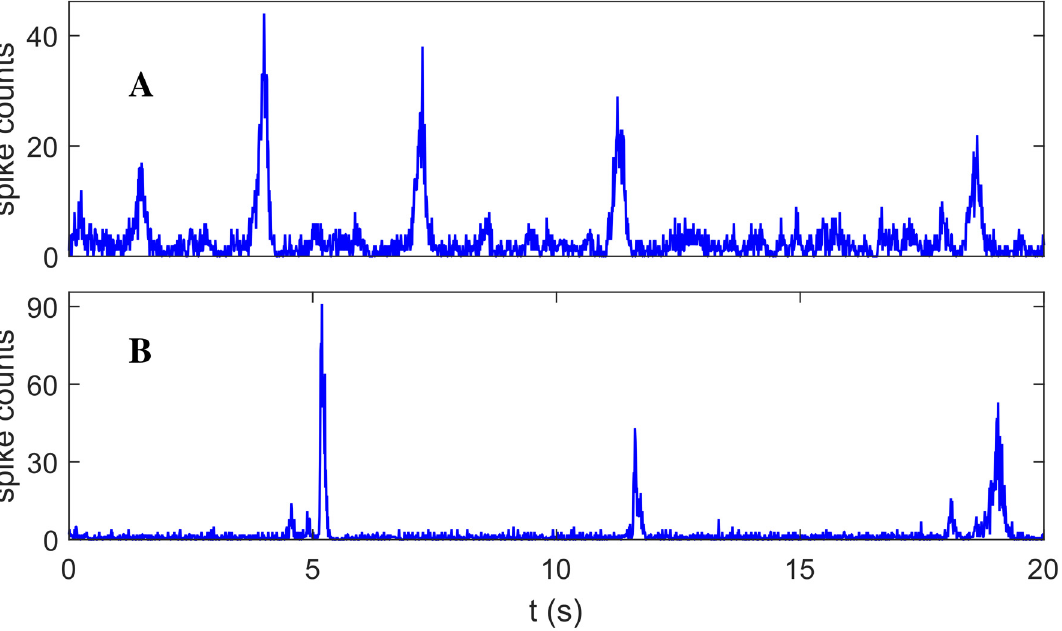
Fig 1. Time course of the network firing rate. Panel A: noisy mean-field simulations; panel B: ex-vivo data. Random large excursions of the firing rate (network spikes and quasi-orbits) are clearly visible in both